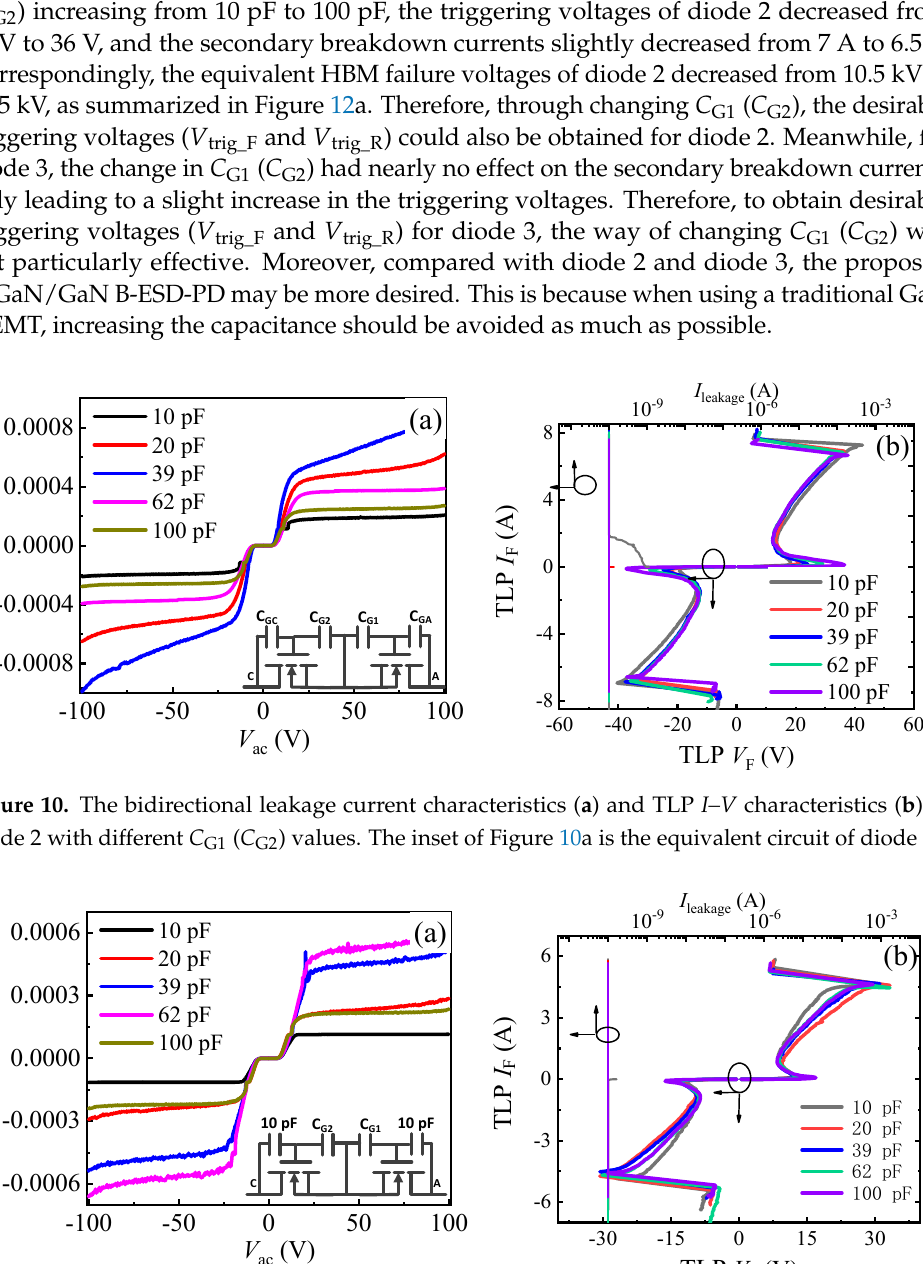
Figure 12. I S , V trig and V HBM of diode 2 ( a ) and diode 3 ( b ) with different C G1 and C G2 values. 4. Conclusions In conclusion, a novel AlGaN/GaN B-ESD-PD featuring two floating gate electrodes and two pF-grade capacitors was proposed for enhancing the ESD robustness of a GaN power system. Through the TLP tests, it was demonstrated that the proposed AlGaN/GaN B-ESD-PD could be triggered by a required voltage (~10 V) and possessed a high second- ary breakdown current in both forward and reverse transient ESD events. Furthermore, it was also found that the required triggering voltages and secondary breakdown currents of the proposed AlGaN/GaN B-ESD-PD were strongly related to C GA ( C GC ). With C GA ( C GC ) increasing from 5 pF to 25 pF, the positive triggering voltages decreased from 18 V to 7 V, and the positive secondary breakdown currents decreased from ~7 A to ~3 A. In addition,